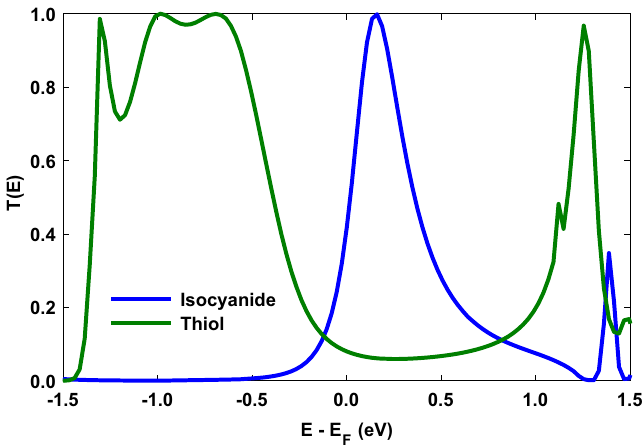
Figure 2. The transmission coefficient versus energy for the anthracene molecule coupled to the Au electrodes via thiol (green) and isocyanide (blue) anchoring groups evaluated at T = 300 K